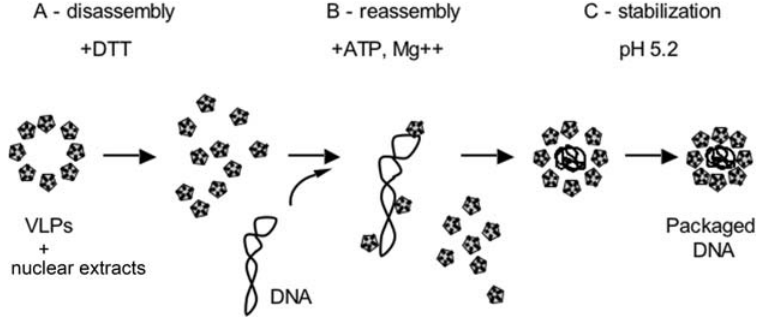
Figure 7. A model for the invitroassembly reaction. The addition of DTT to nuclear extracts (A) leads to disassembly of the VLPs. Following the addition of supercoiled DNA (B) pentamers bind along each DNA molecule. This increases the local concentration of VP1, facilitating concerted assembly. Reassembly may be facilitated by presence of chaperones in the nuclear extracts. Assembly is accompanied by DNA condensation, presumably via the action of topo II. In Step C the capsids are stabilized at pH